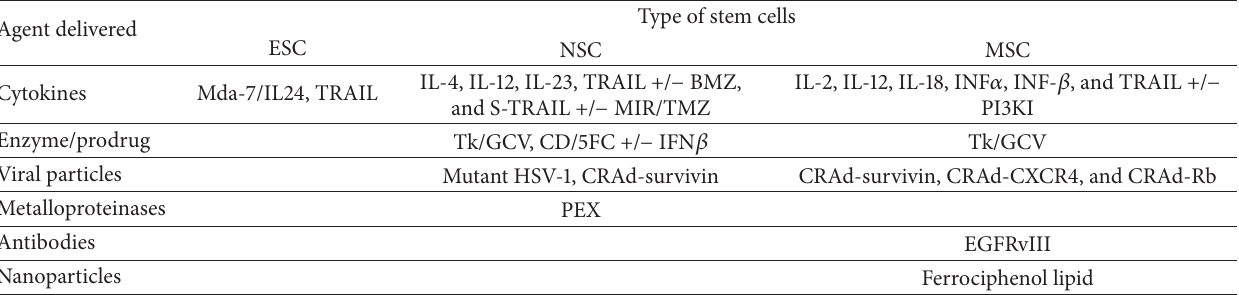
Table 2: Therapeutic agents delivered by SC for the treatment of